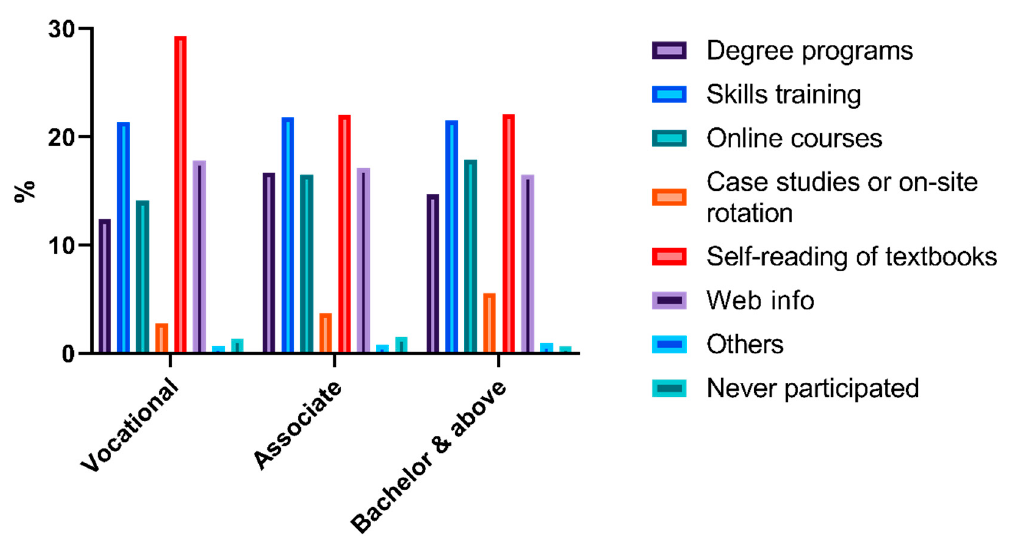
Figure 2. Histogram of capacity enhancement activities based on education level.